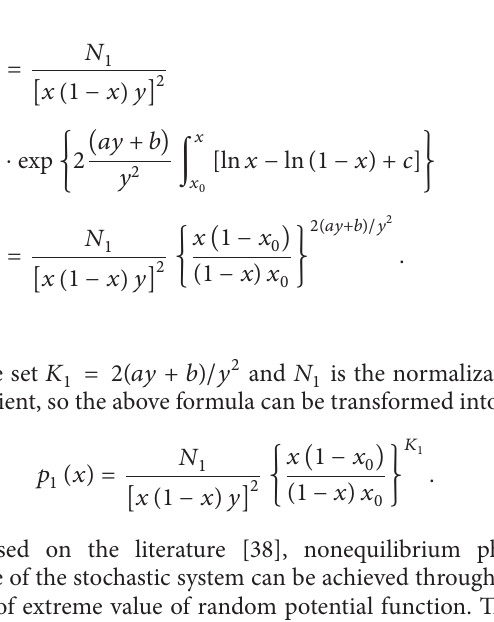
Table 4: The results of 𝑈 󸀠